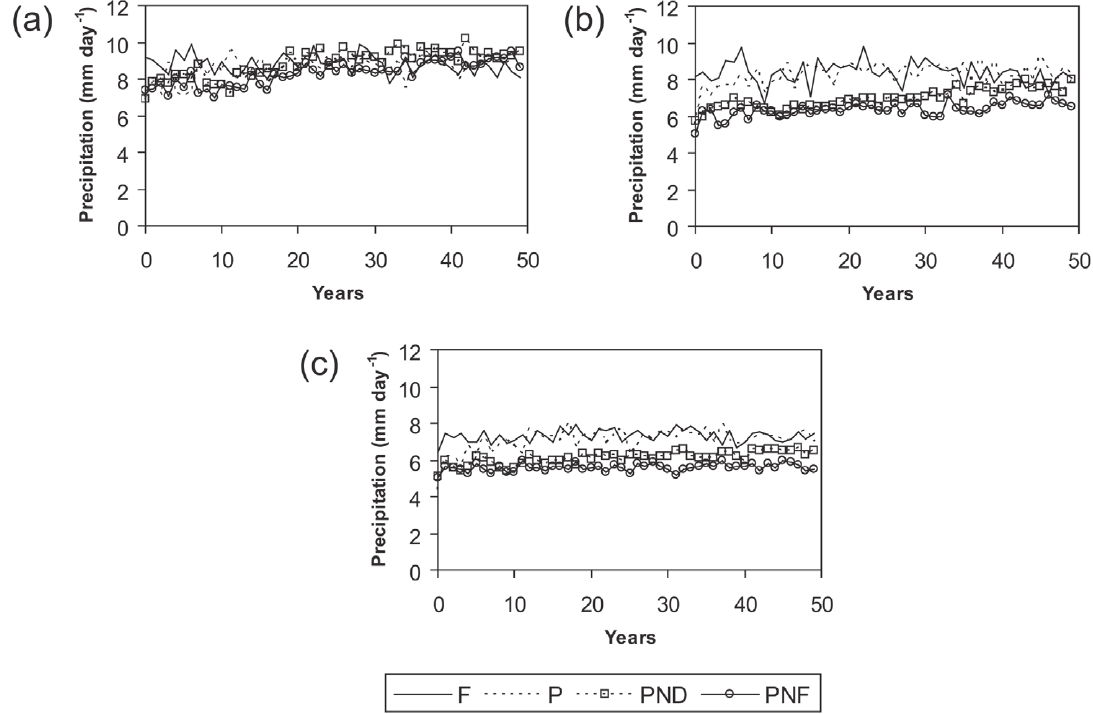
Fig. 2 - The simulated annual mean precipitation for (a) region 1 - Colombia and northwestern state of Amazonas, (b) region 2 - central Amazonia above 10° S, and (c) region 3 - northern state of Mato